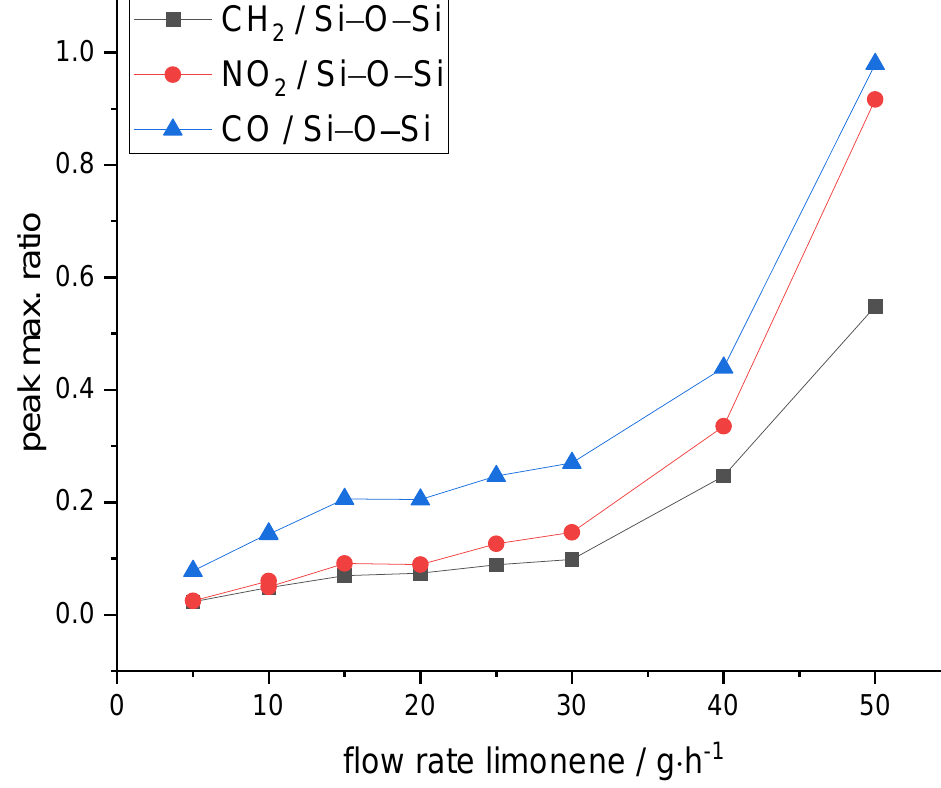
Figure 6. Ratios of peak maxima of FTIR absorption of CH 3 , CO and NO 2 stretching mode divided by Si-O-Si mode at a fixed HMDSO flow rate of 10 g · h − 1 and different limonene flow rates.